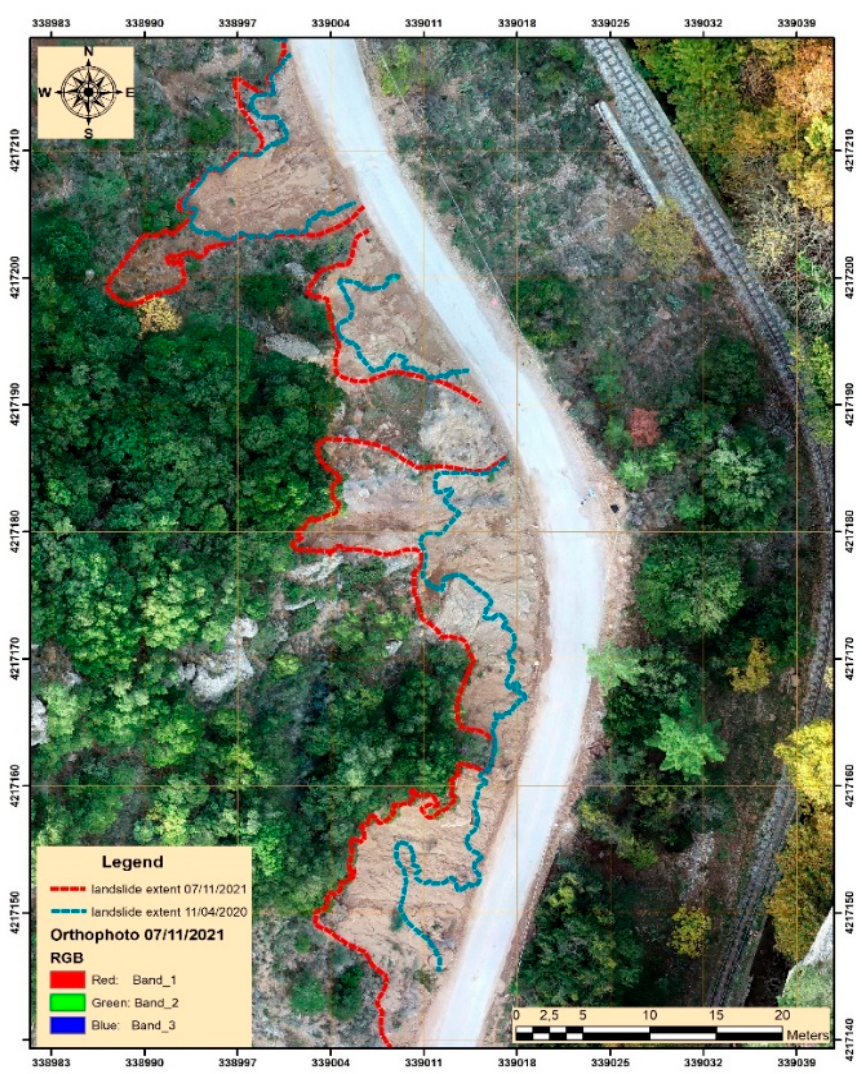
Figure 9. Evolution of the extent of the mass movements over time.